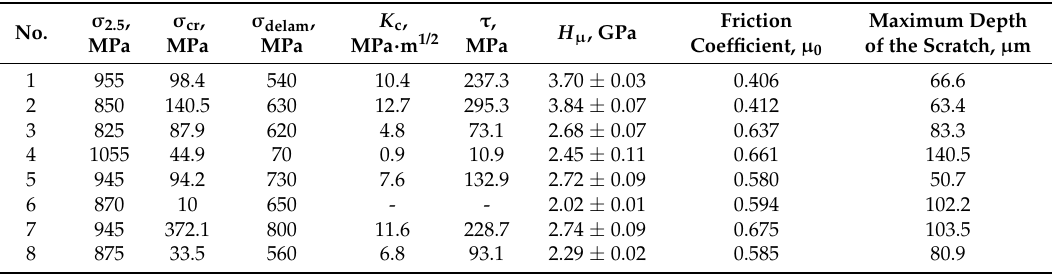
Figure 1. ( a ) three-point bending diagram for coated titanium specimens; ( b , c ) scratching diagrams of the coatings. Table 2. Mechanical properties of the coatings and coated specimens measured by scratch tests and 3-point bending.